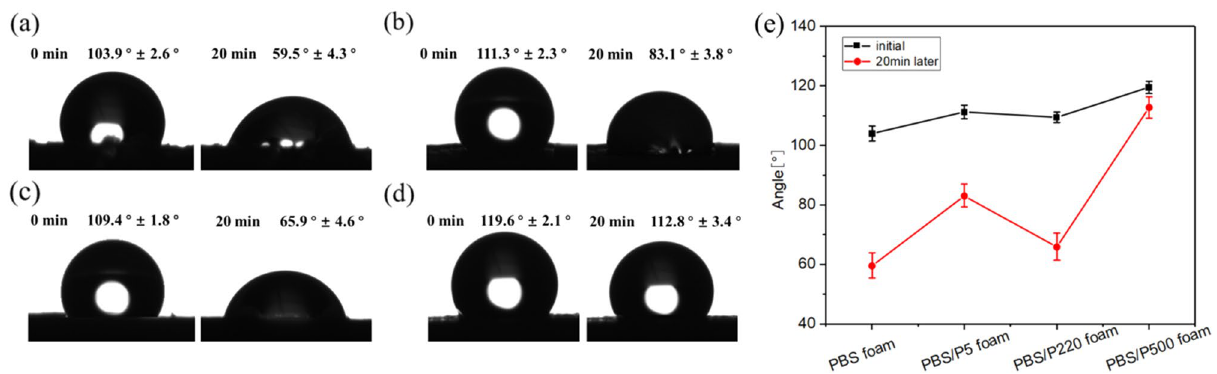
Figure 13. Water contact angle values of PBS and PBS/PTFE composite foams: ( a ) neat PBS, ( b ) PBS/P5, ( c ) PBS/P220, ( d ) PBS/P500, and ( e ) statistical